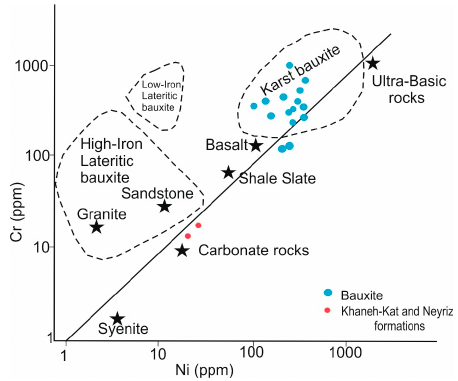
Figure 11. Binary diagram of Cr versus Ni to imply parent rock (after [2,11,22,56]). The Dopolan data plot in the karst bauxite field. The Khaneh–Kat data plot near the carbonate rocks. plot in the karst bauxite field. The Khaneh–Kat data plot near the carbonate